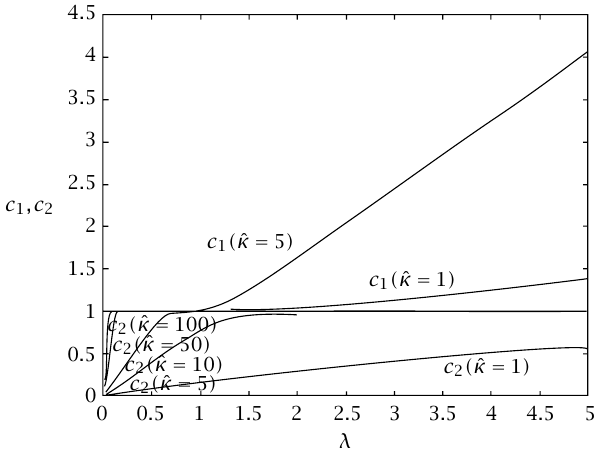
Figure 3.2 . The velocities c 1 and c 2 as functions of λ ( 0 ≤ λ ≤ 5 ) for fixed values of ˆ κ